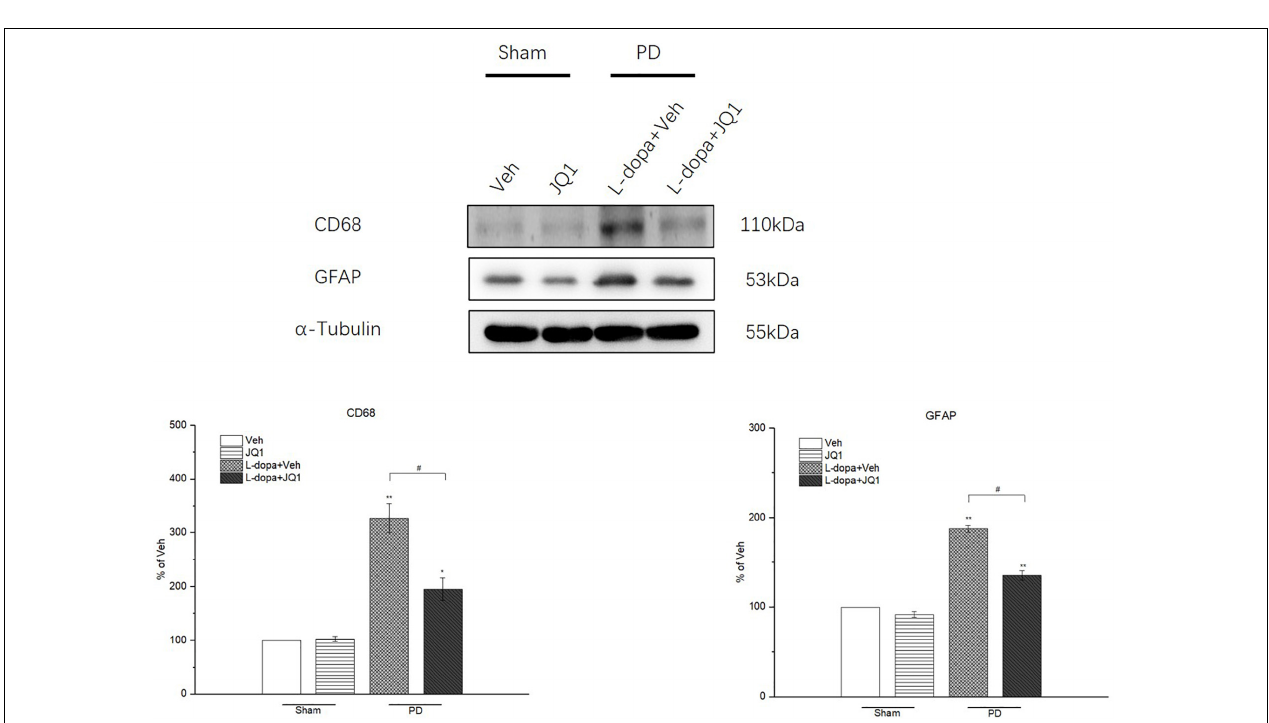
FIGURE 7 | Changes in the CD68 and GFAP expressions in the saline- or 6-OHDA-lesioned striatum after 21 days of administration. Both L-dopa and L-dopa + JQ1 treatment groups showed an aberrant increase in the protein level of CD68 and GFAP in the 6-OHDA-lesioned striatum of rats after 21 days of treatment ( p < 0.01 vs. Veh group). The protein level of CD68 and GFAP in the L-dopa treatment group was much higher than that in the L-dopa + JQ1 treatment group ( p < 0.01). JQ1 barely affected the CD68 and GFAP protein expressions in the saline-lesioned striatum of the JQ1 treatment group ( p > 0.05 vs. Veh group). The protein levels expressed relative to α -tubulin levels. The data are expressed in terms of mean ± SD and as a percentage of the Veh group. ** p < 0.001 vs. Veh group, * p < 0.01 vs. Veh group, # p < 0.01 vs. L-dopa treatment group ( n = 3 per group).